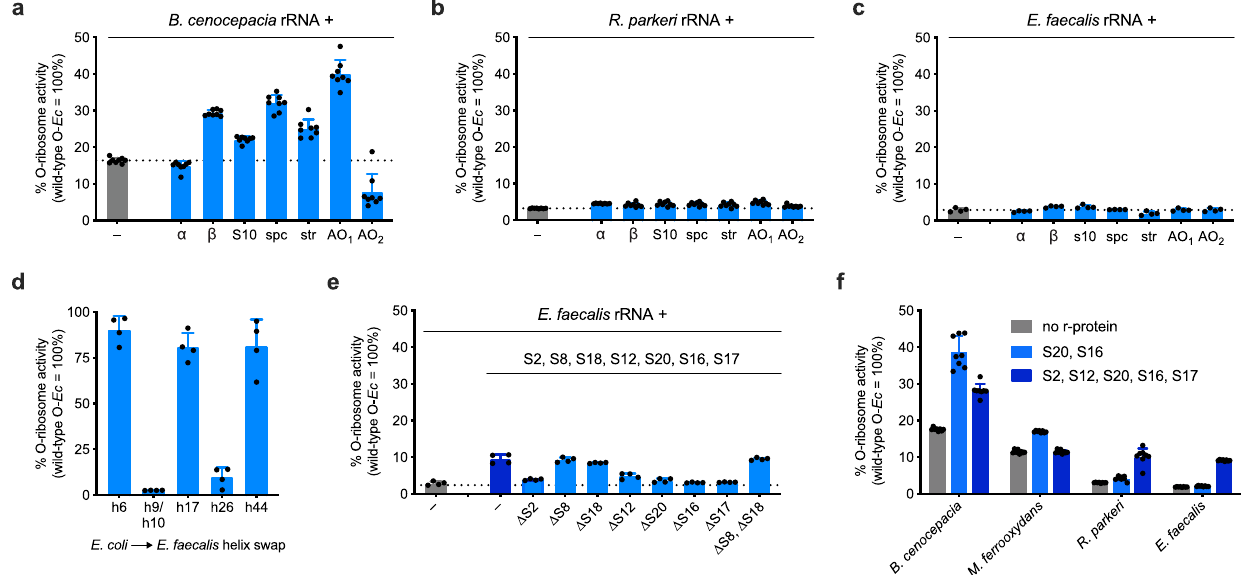
Fig. 5 Phylogenetically guided determination of cognate r-proteins that improve highly divergent heterologous O-ribosomes in E. coli . a – c No single contiguous operon substantially improves translation activity of O-rRNAs derived from a B. cenocepacia ( n = 8), b R. parkeri ( n = 8), or c E. faecalis ( n = 4). d Only 2 of the identi fi ed 5 regions with high sequence divergence between E. coli and E. faecalis 16S rRNAs abrogate E. coli O-translation when replaced with cognate E. faecalis sequences ( n = 4). e Cognate S2, S8, S18, S12, S20, S16, and S17 (which directly contact h9, h10, and h26 49 ) result in an increase in E. faecalis O-rRNA translation. Further analysis showed that S8 and S18 are not required for this increase ( n = 4). f R-proteins S2, S12, S20, S16, and S17 collectively improve cognate O-rRNA translation for highly divergent species, but are not as effective as S20 and S16 alone for less divergent species. E. faecalis cognate ribosomal proteins (r-proteins) are expressed from a low copy number backbone (WT RepA SC101 origin) to limit toxicity ( n = 8). Data re fl ect the mean and standard deviation of 4 – 8 biological replicates. Comprehensive O-translation data reported in Supplementary Table 1. Wild-type O- Ec wild-type orthogonal E. coli , O-ribosome orthogonal ribosome, h helix. Source data are available in the Source Data